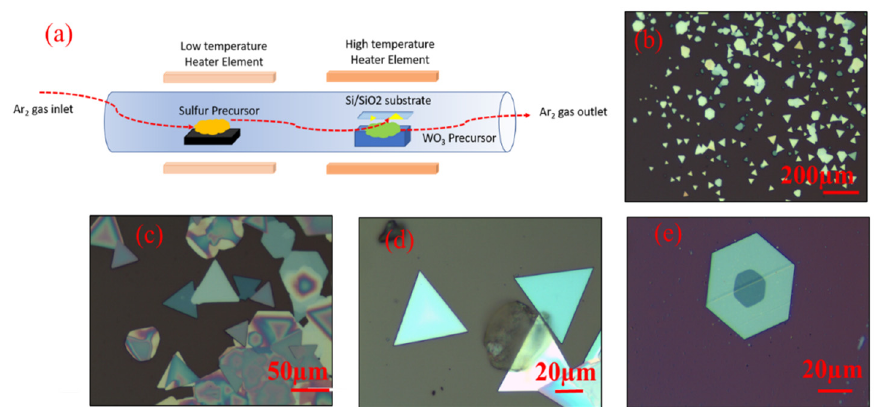
Figure 1. ( a ) Experimental setup. ( b – e ) Optical images of synthesized WS 2 film showing the pres- ence of mono-to-few layered WS 2 on Si/SiO 2